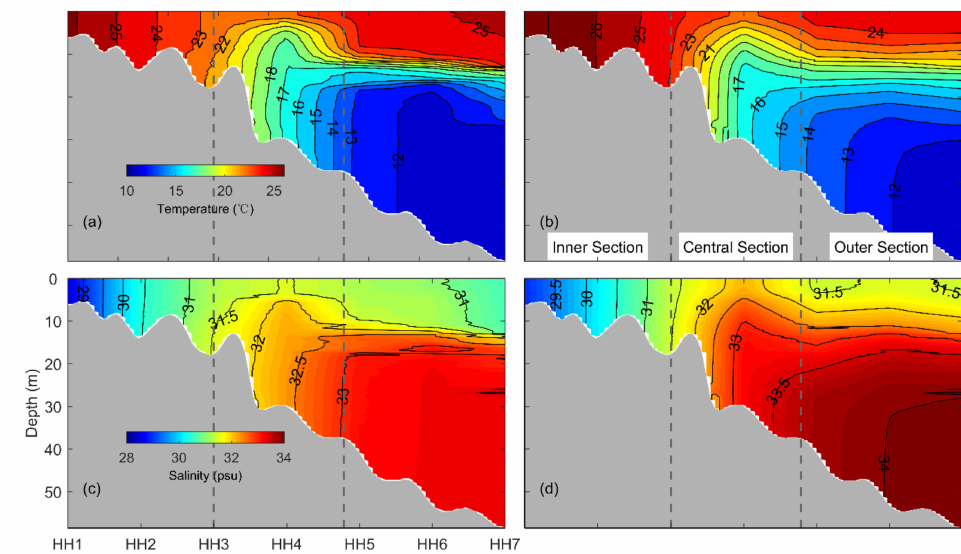
Figure 7. Vertical distribution of temperature ( a , b ) and salinity ( c , d ) along transect HH